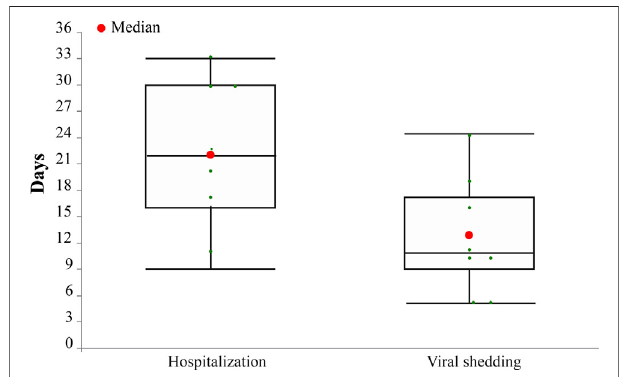
FIGURE 6 | Duration of hospitalization and viral shedding in eight COVID-19 cases (days).